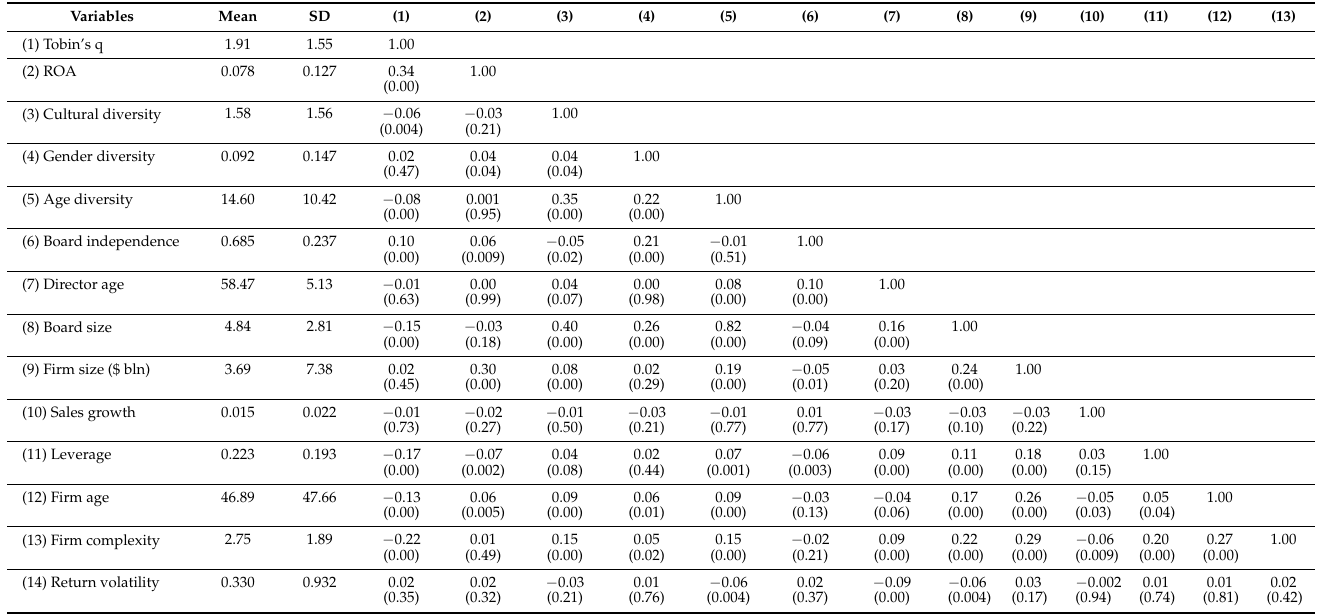
Table 2. Summary statistics and